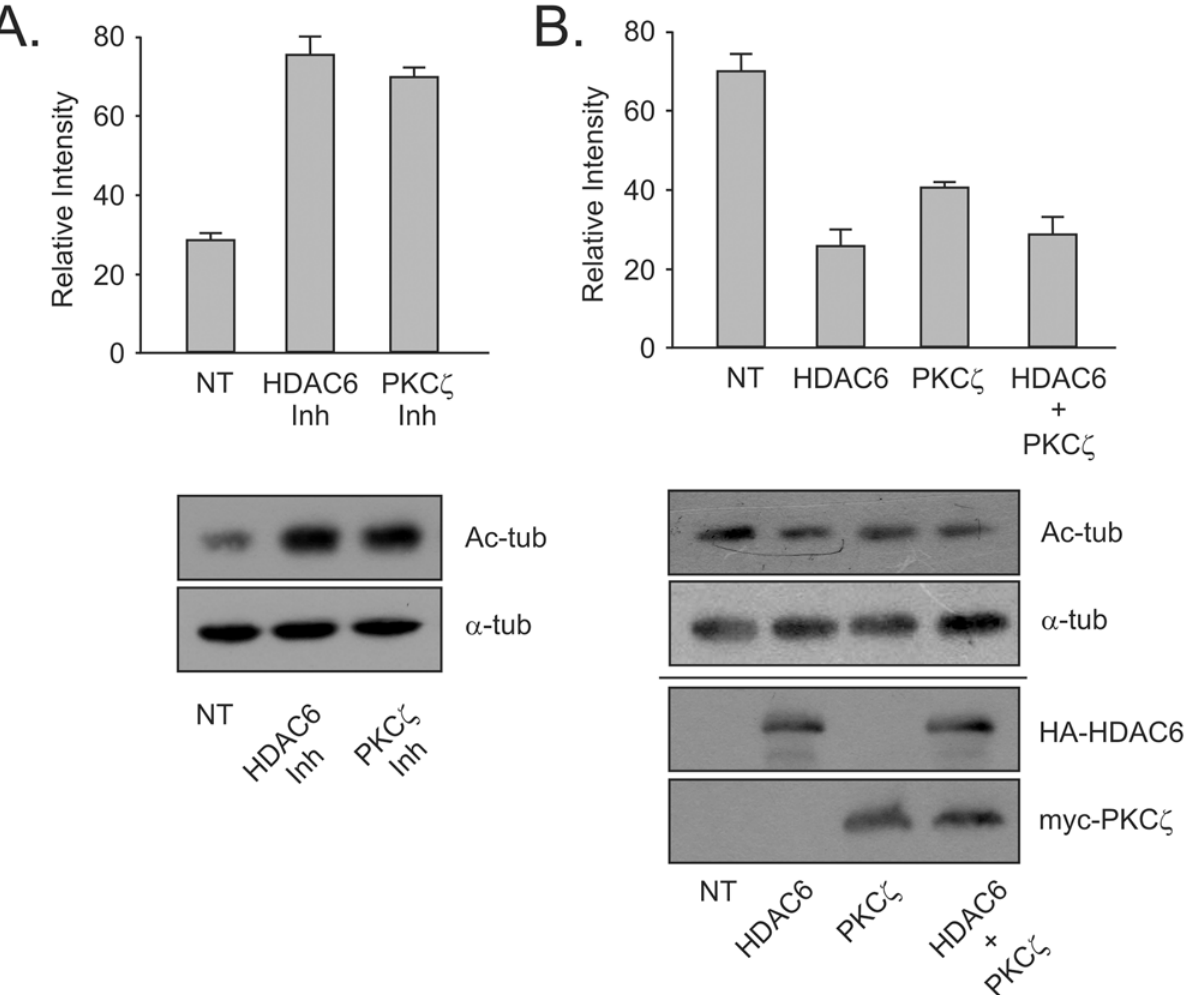
Fig 3. Phosphorylation by atypical PKC ζ upregulates the deacetylase activity of HDAC6. (A) MEF cells were treated with HDAC6 inhibitor (tubacin — 10 μ M for 4 hours) or aPKC inhibitor (myristoylated pseudosubstrate — 20 μ M for 16 hours) and HDAC6 endogenous activity was assessed using changes in acetylated-tubulin levels. A total of 40 μ g whole cell lysate was loaded in each lane. (B) HA-HDAC6 and myc-PKC ζ were expressed separately or in concert in HEK cells and acetylated tubulin levels assessed by SDS-PAGE and Western blotting. Expression blots for lysates were loaded with 40 μ g lysate protein. Results are indicative of 3 independent